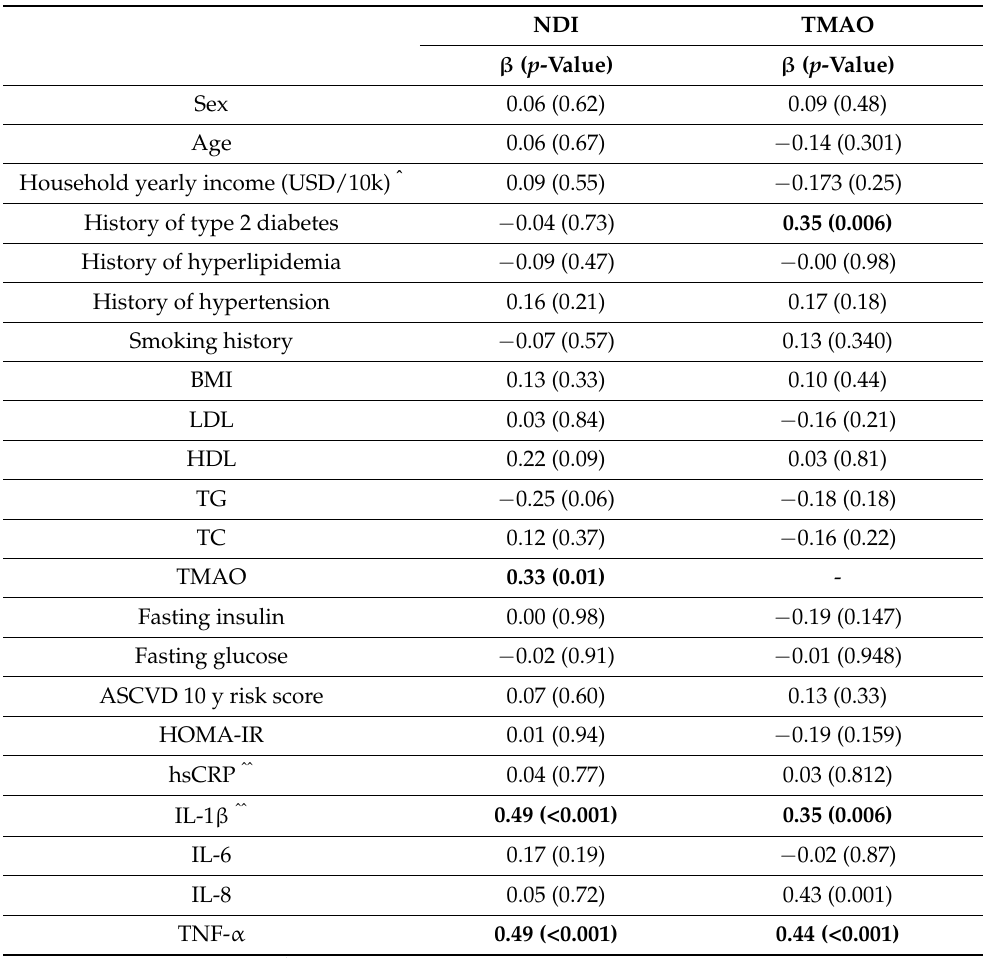
Table 2. Bivariate associations between neighborhood deprivation index (NDI) and trimethylamine- N-oxide (TMAO) levels with sociodemographics, CVD risk factors, and inflammatory markers ( n = 60). NDI TMAO β ( p -Value) β ( p -Value) Sex 0.06 (0.62) 0.09 (0.48) 0.06 (0.67) − 0.14 (0.301) Household yearly income (USD/10k) ˆ 0.09 (0.55) − 0.173 (0.25) History of type 2 diabetes − 0.04 (0.73) 0.35